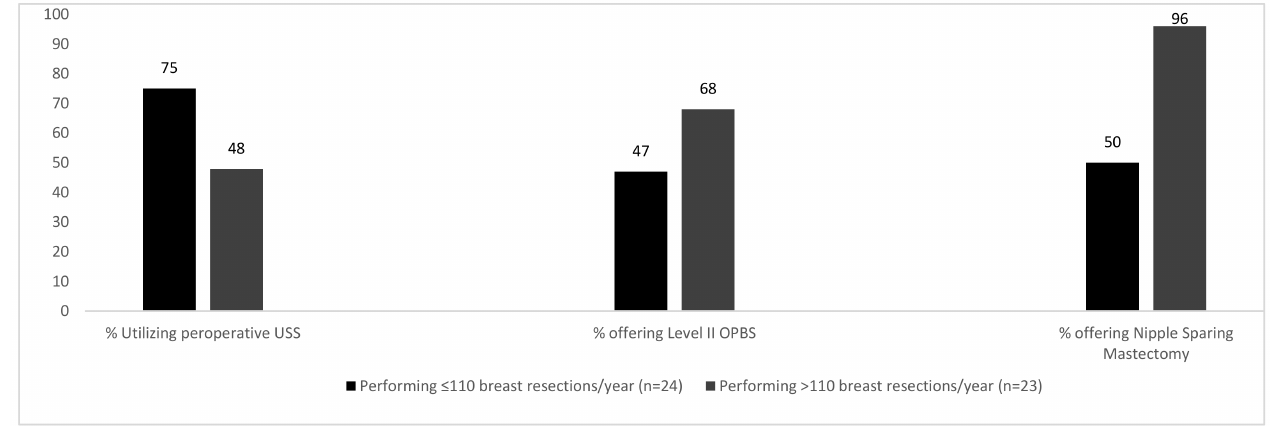
Figure 3. % of participants responding to various questions broken down by volume of annual breast resections. 75% of surgeons performing a lower volume of breast cases per year reported using breast ultrasound assessment preoperatively (which is not supported by practice guide- lines). Conversely, higher volume breast surgeons report using pre-operative US only 48% of the time. ‘Low-volume’ breast surgeons were more likely to have their intraopera- tive specimen X-rays performed and read by a radiologist whereas ‘high volume’ breast surgeons were more likely to perform and read intra-operative X-rays